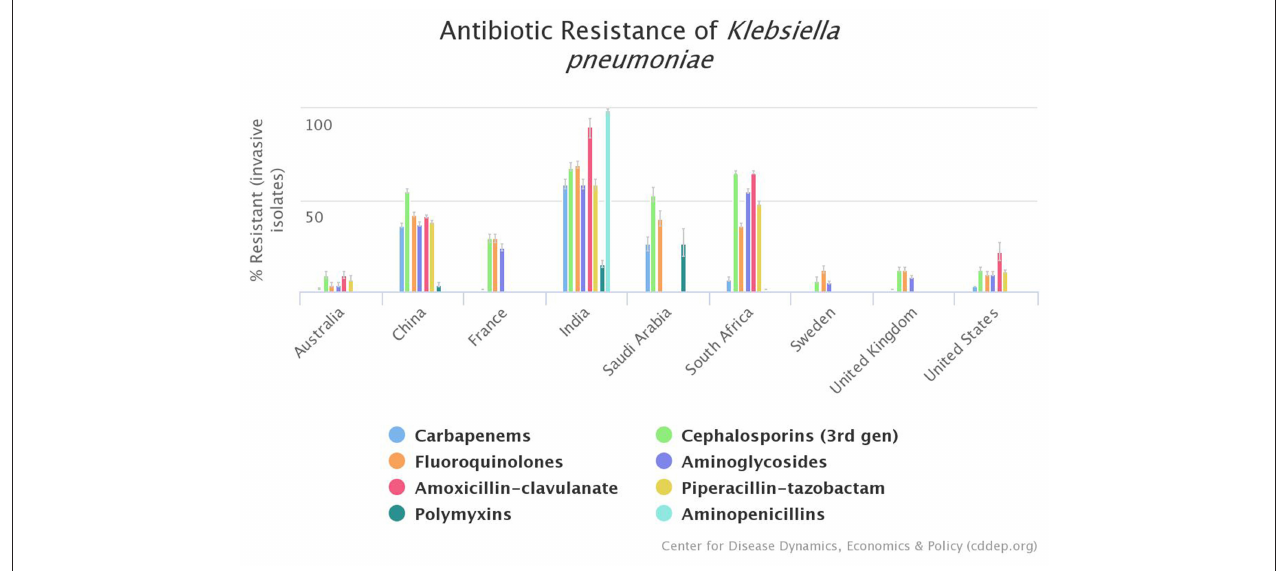
FIGURE 1 | Graphical representation of existing disparity between high-income countries (HICs) and lower-middle-income countries (LMICs) regarding antimicrobial resistance profile of K. pneumoniae ; according to Center for Disease Dynamics, Economics, & Policy (CDDEP) data (37).